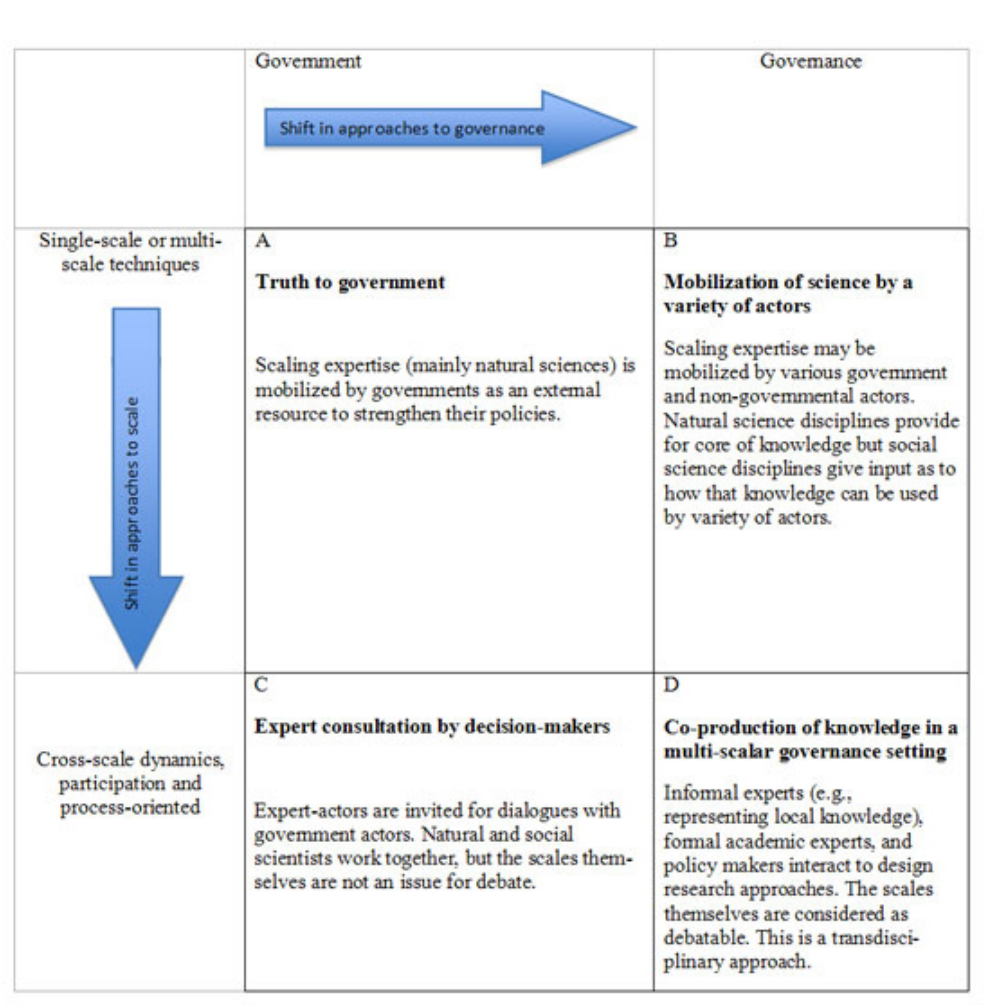
Fig. 2 . Shifts in the scale and governance